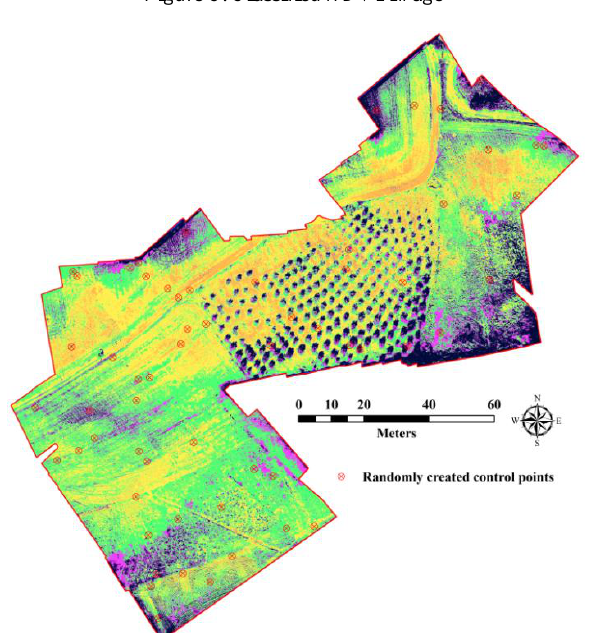
Figure 5. Classified NDVI image